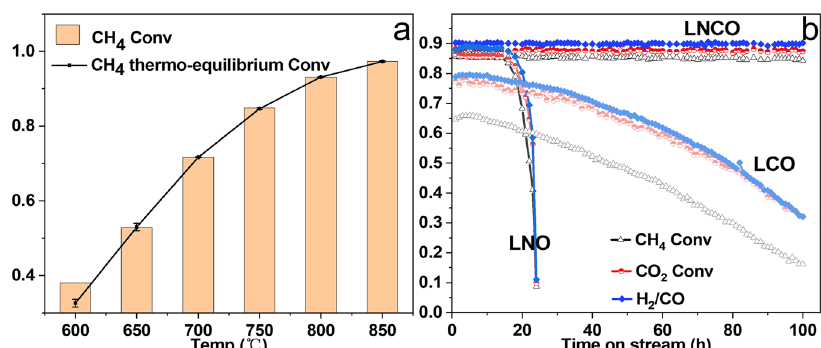
Fig. 1 DRM performance over LNCO, LNO, and LCO catalysts. a Temperature-dependent CH 4 conversion between 600 and 850°C over LNCO catalyst, b DRM performance over LNCO, LNO, and LCO catalysts at 750 °C. Conditions: CH 4 :CO 2 = 1:1, total fl ow rate = 60 sccm (GHSV = 1.2× 10 4 mL g cat − 1 h − 1 ). LNCO, LNO, and LCO represent LaNi 0.05 Co 0.05 Cr 0.9 O 3 , LaNi 0.1 Cr 0.9 O 3 , and LaCo 0.1 Cr 0.9 O 3